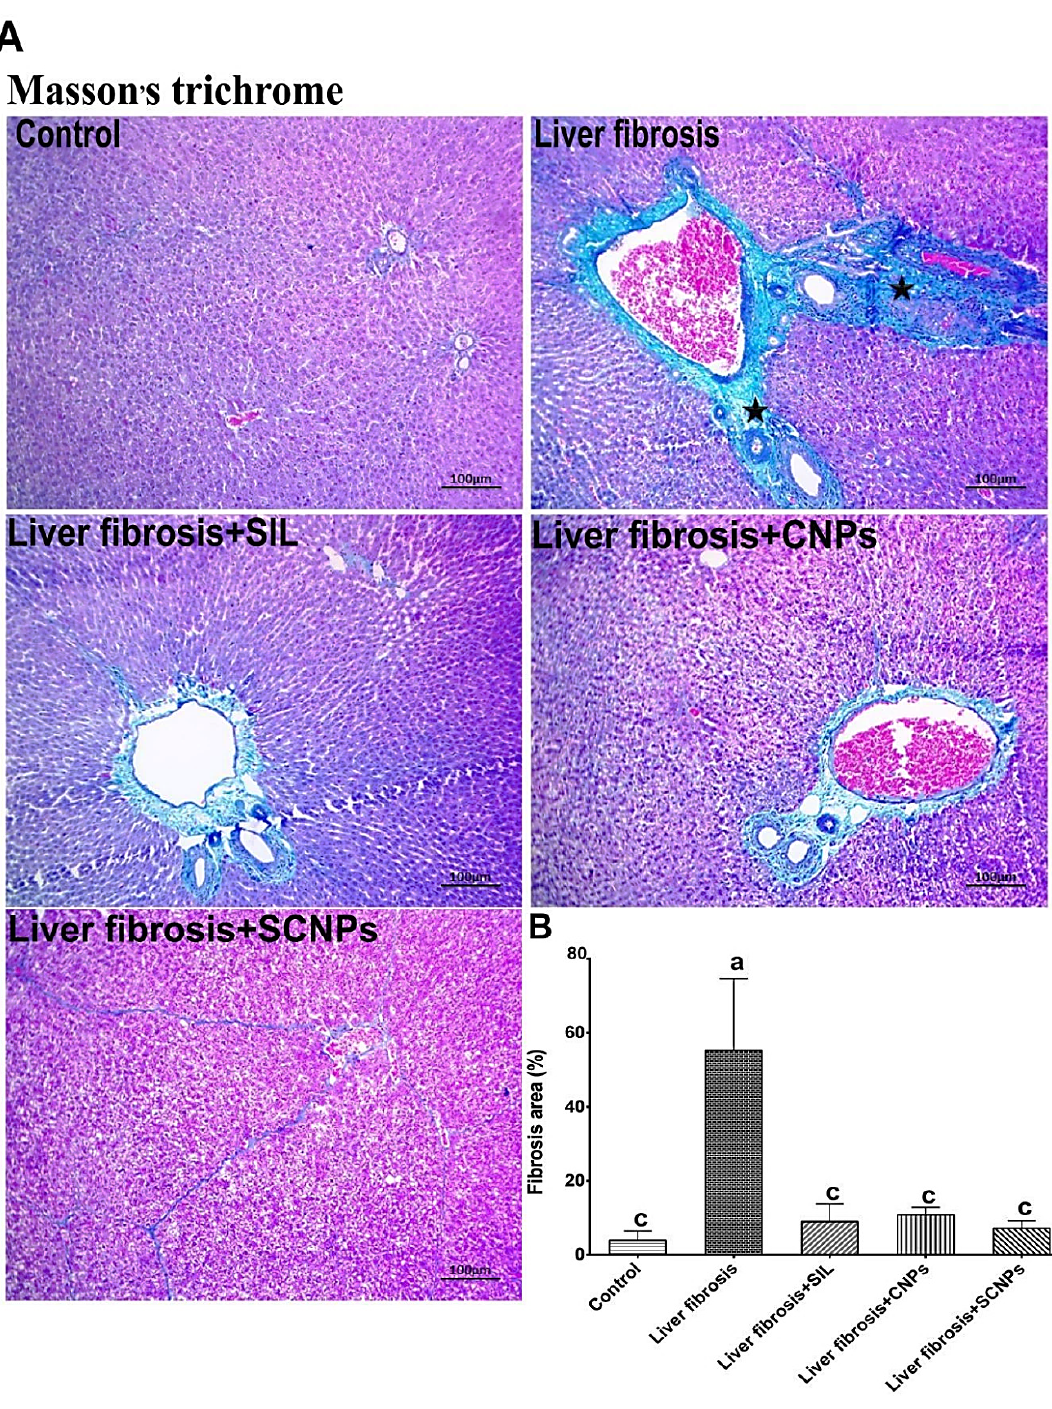
Figure 11. ( A ) Mason’s trichrome (MT) stained liver sections under microscope; CCl 4 -induced hepatic fibrosis shows intense blue satiable materials in the portal area, which extended to the interlobular (stars); however, other groups show characters of fibrosis unevenly except SCNPs, which show a significantly reduced degree of liver fibrosis. ( B ) Fibrosis scores of the different groups were determined by ImageJ software as MT areas percent (fibrosis area % per 10 fields in magnification power × 100). Data are presented as mean ± SD ( n = 6). The means of the groups in the same column with the same superscript letter are not significantly different, while the means with different letters are significantly differed according to the ANOVA test, followed by the post hoc test (Tukey). At p ≤ 0.05, the difference was statistically